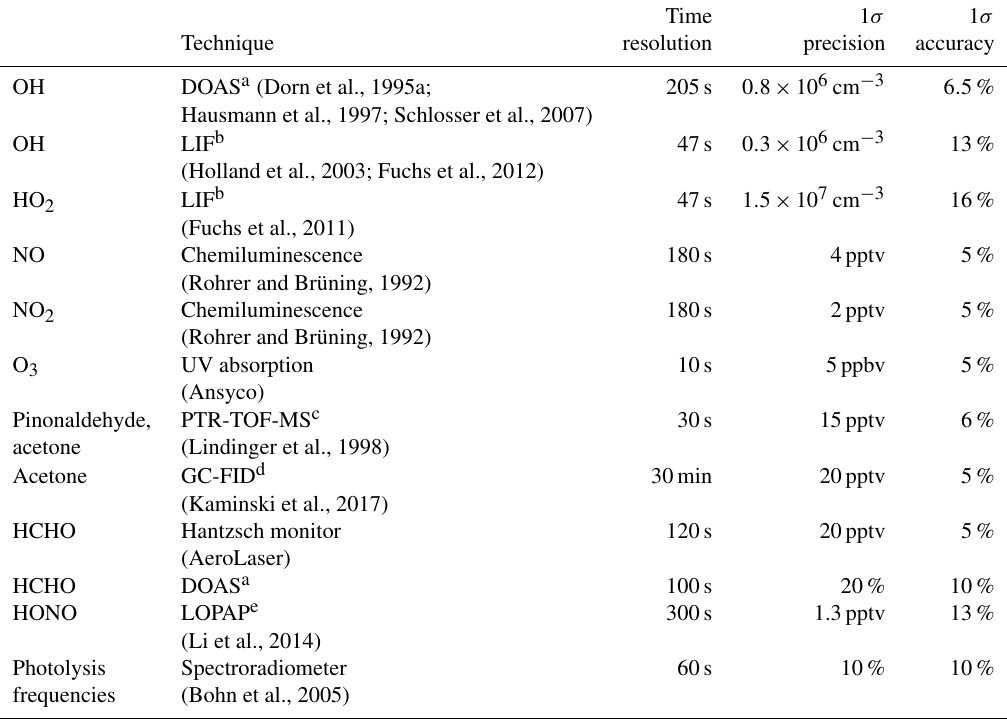
Table 1. Instrumentation for radical and trace gas detection during the pinonaldehyde oxidation experiments.